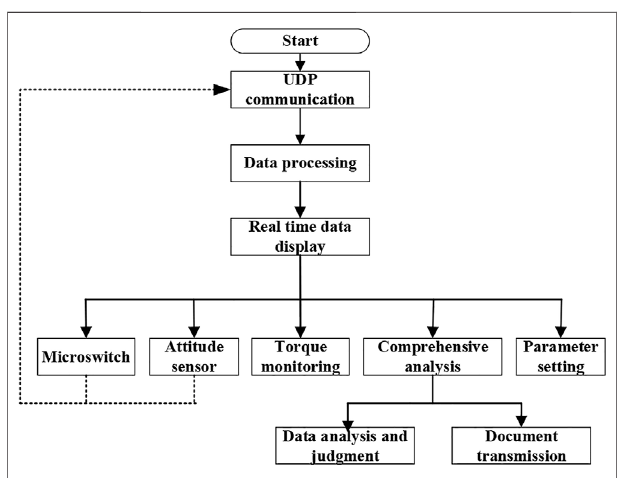
FIGURE 5 | Software design